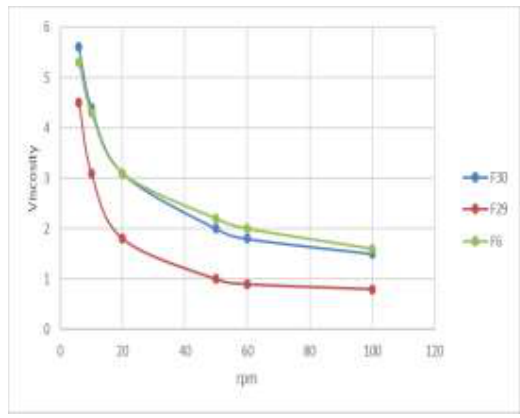
Figure 5.Viscosity (Pa/s) of F6, F29 and F30 at different rpm at 37°C Determination of gel strength Formulations with higher concentration